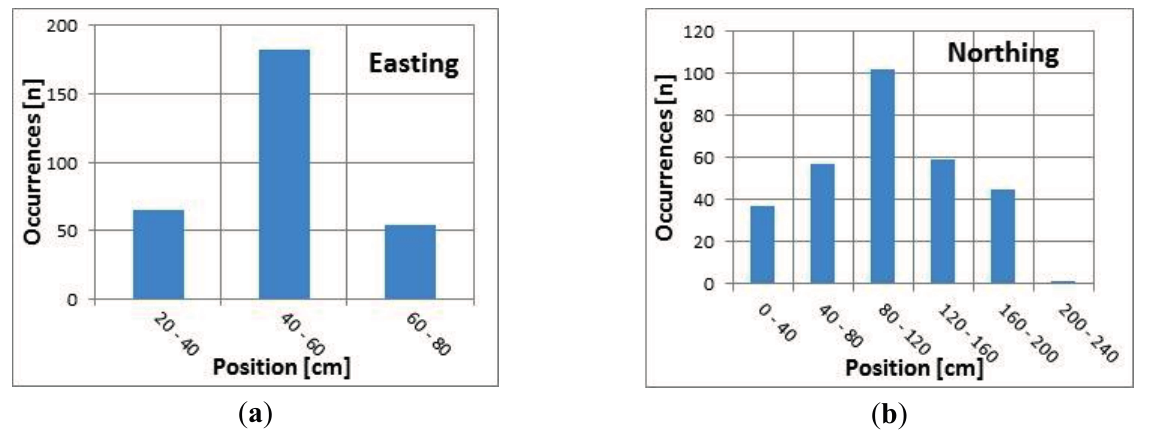
Figure 6. GNSS easting ( a ) and northing ( b )